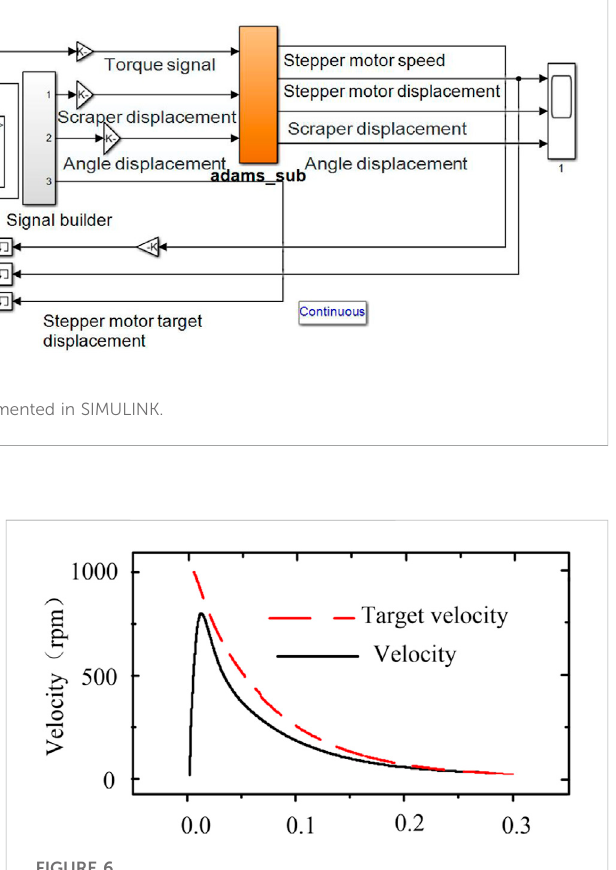
FIGURE 6 The velocity and velocity target response curve of Xmotor under 50 mm target displacement is obtained by